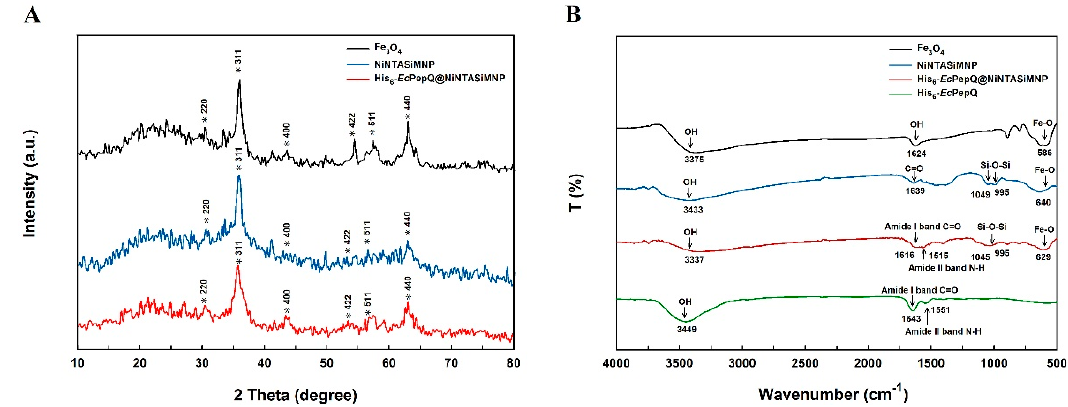
Figure 4. XRD ( A ) and FTIR ( B ) spectra of bare and enzyme-immobilized NiNTASiMNPs.